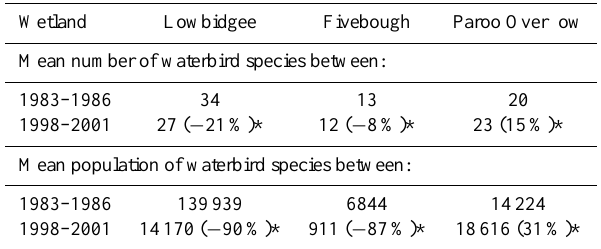
Table 2. Annual trends in waterbird abundance in three wetland systems, including the Lowbidgee (1983 to 2001) (Kingsford and Thomas, 2004).